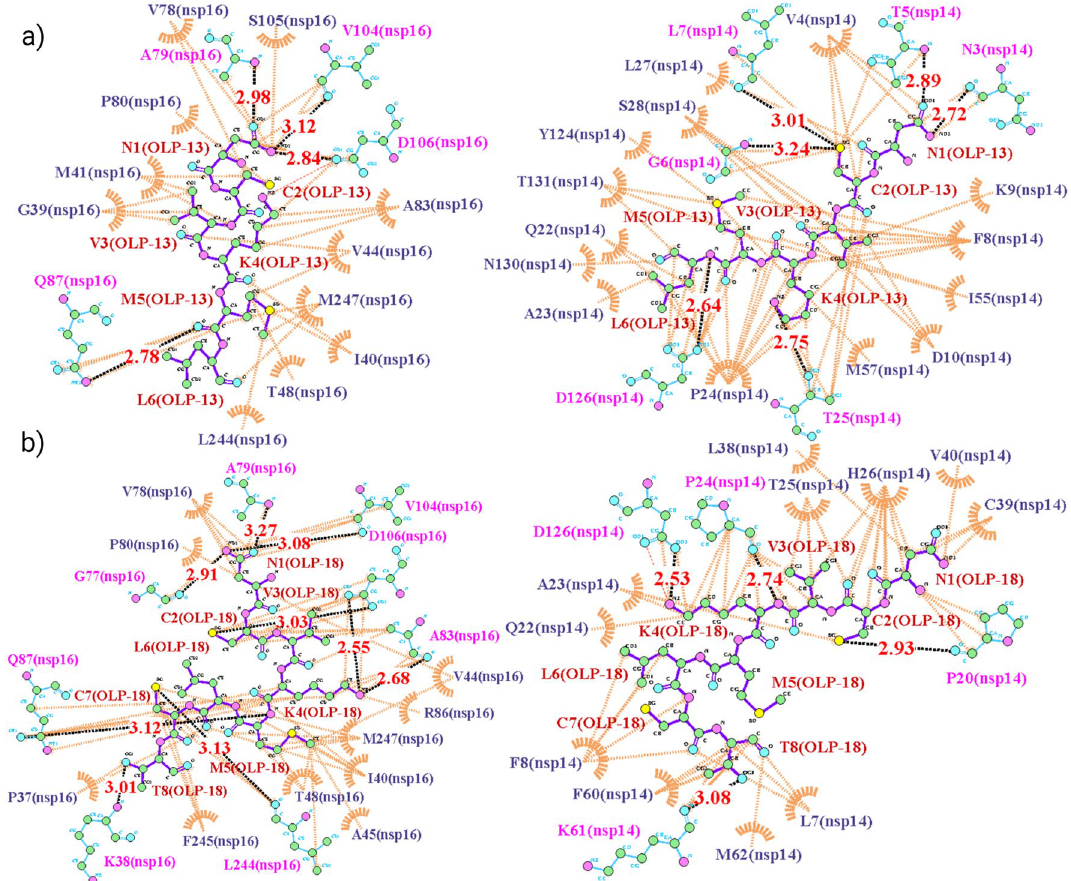
Figure 4. The maps of peptide–protein interactions for the OLP-13 and OLP-18 peptides and their targets (nsp16 and nsp14). ( a ) Peptide–protein interactions of OLP-13 with nsp16 (left) and nsp14 (right) as the target proteins. ( b ) Peptide–protein interactions of OLP-18 with nsp16 (left) and nsp14 (right) as the target proteins. The black dashed lines and the brown arcs with spokes represent the hydrogen bonds and the hydrophobic contacts,